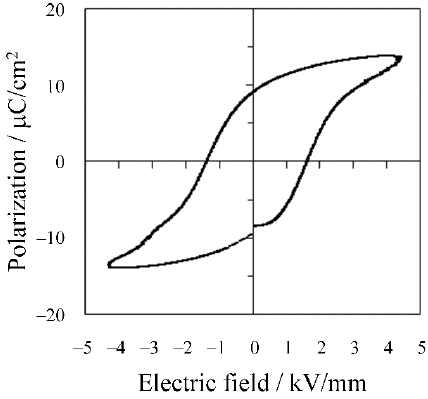
Figure 5. P ‐ E hysteresis curve for multilayer KNN ‐ CZ ‐ 2 sample. Figure 5. P-E hysteresis curve for multilayer KNN-CZ-2